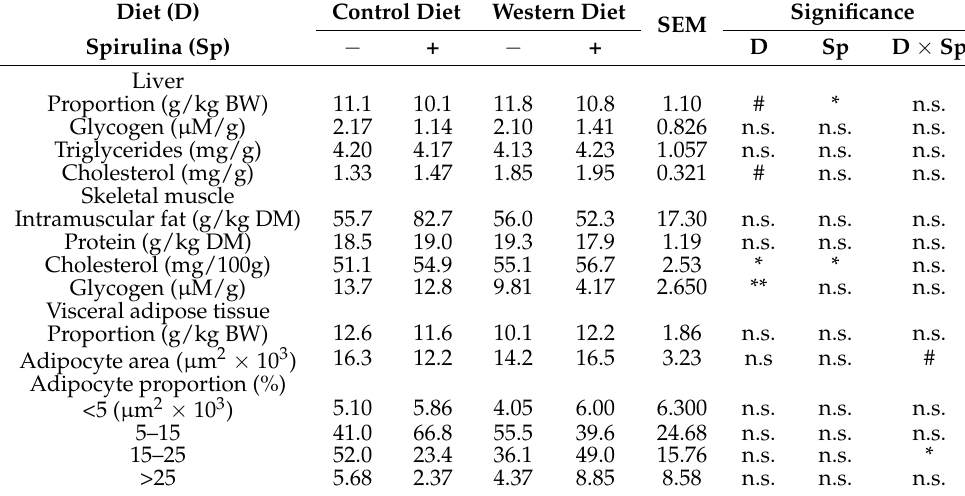
Table 3. Liver, skeletal muscle, and visceral adipose tissue composition of sows following 34 weeks of control (CTR) or Western (WES) diet feeding. Spirulina supplementation was started from week nine for half of the CTR/WES groups.